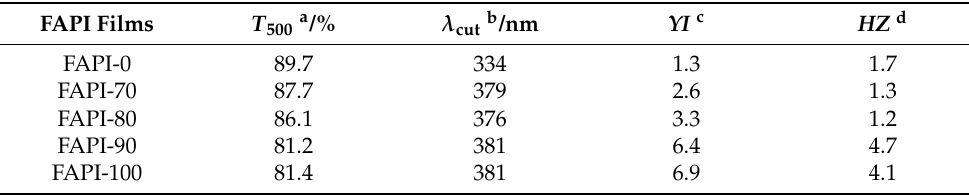
Table 2. Optical data of the FAPI films.